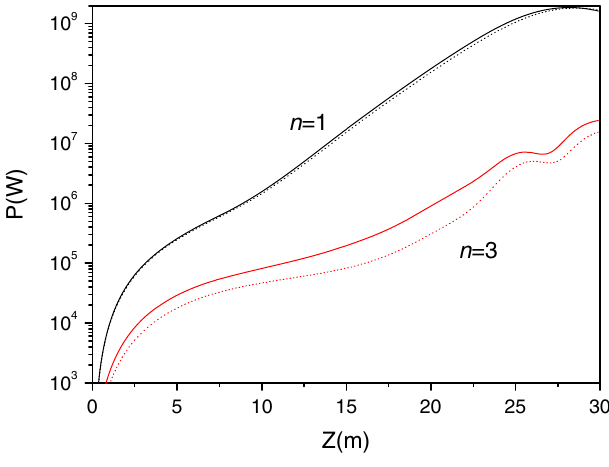
FIG. 5. The nonlinear harmonic generation in SASE FEL with (solid line) and without (dashed line) third harmonics magnetic field. The third harmonics magnetic field 30% of the fundamen- tal and with an opposite phase to the fundamental is considered.